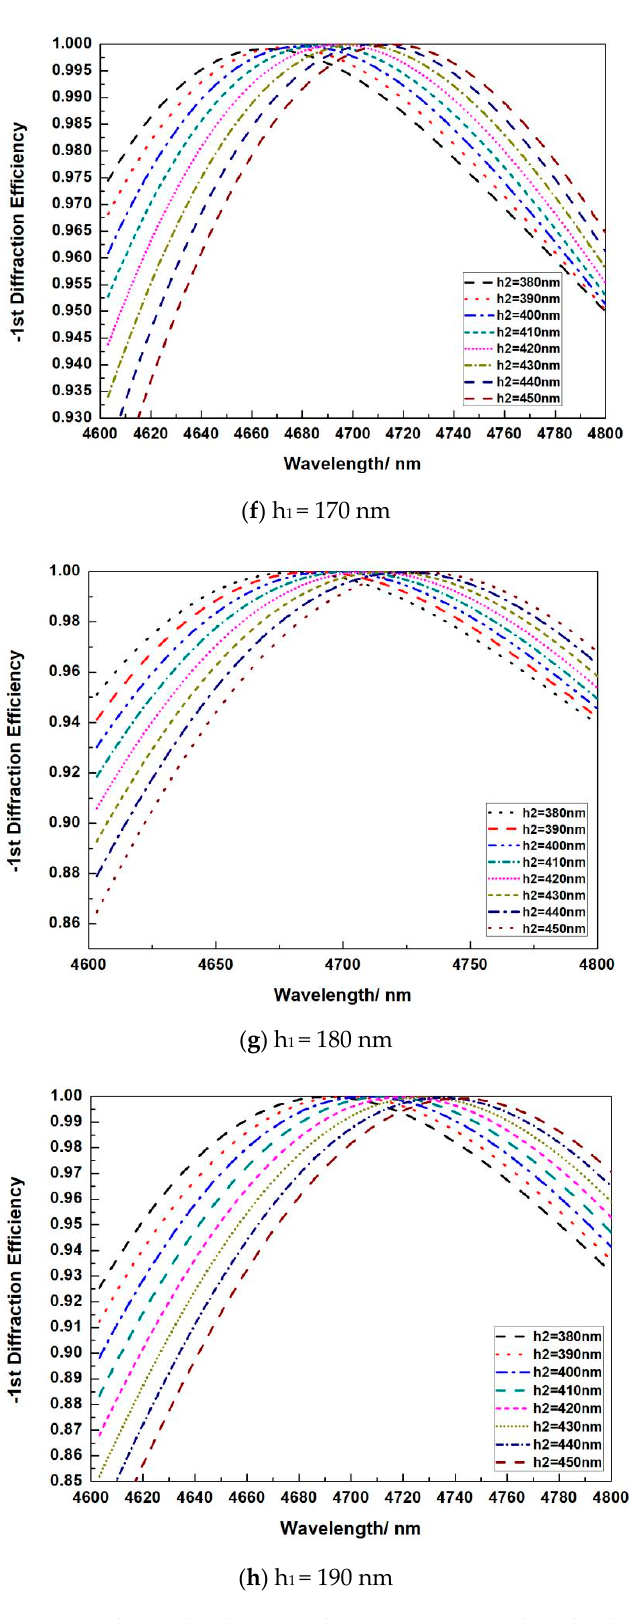
Figure 5. Relationship between the DE versus wavelength when height of SiO 2 h 2 changes